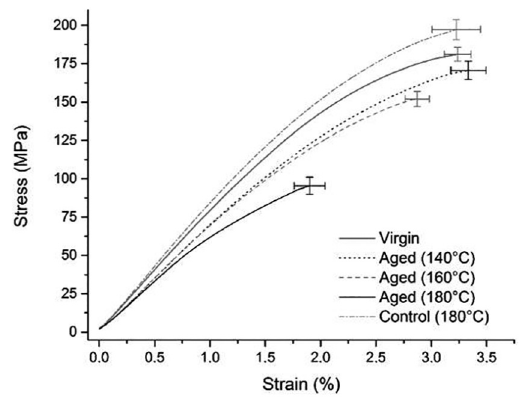
Figure 2: Plot of three-point bending test curves.